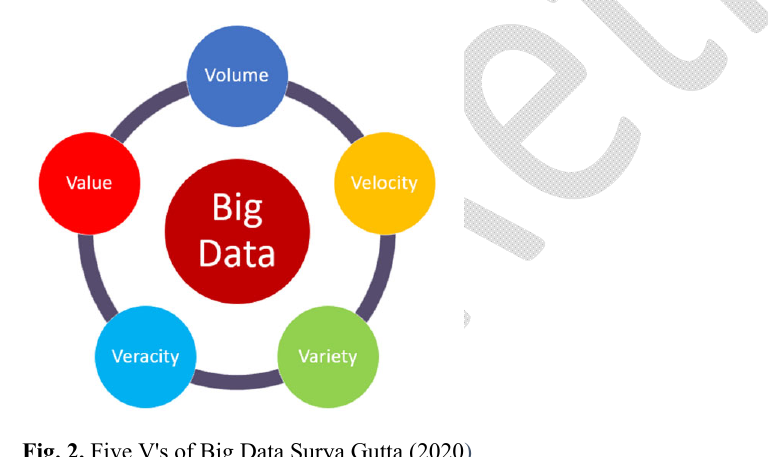
Fig. 2. Five V's of Big Data Surya Gutta